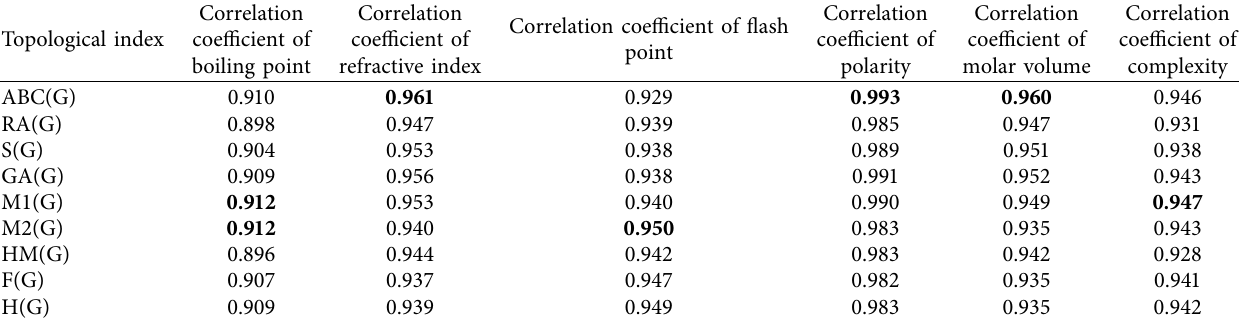
Table 2: Correlation